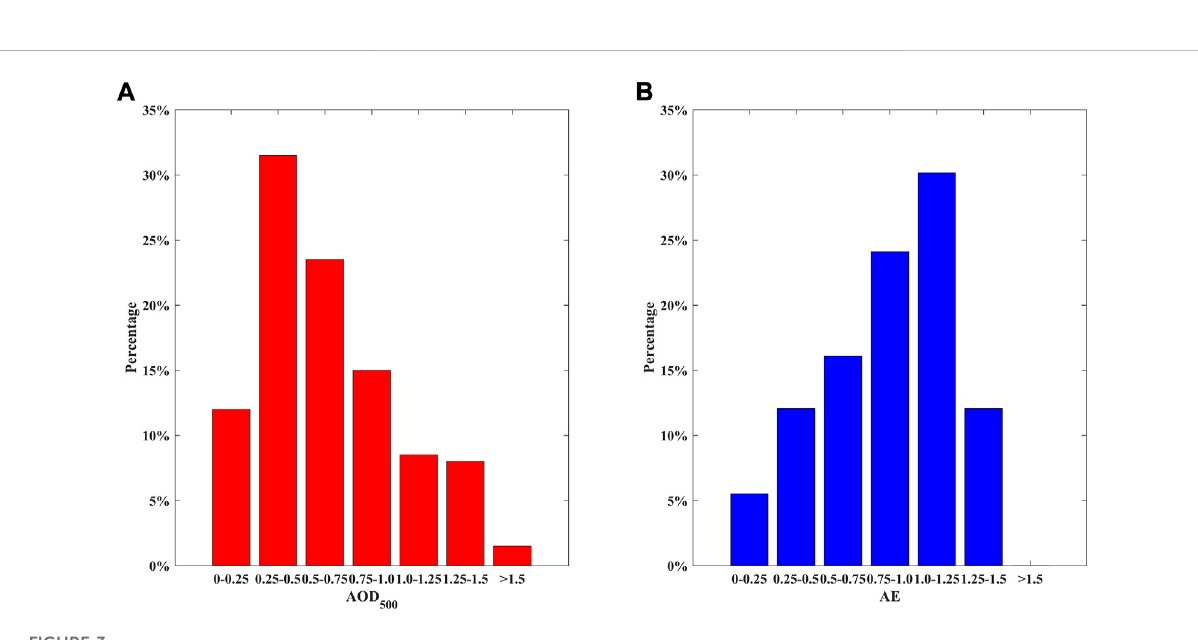
FIGURE 3 The frequency distribution AOD (A) and AE (B)